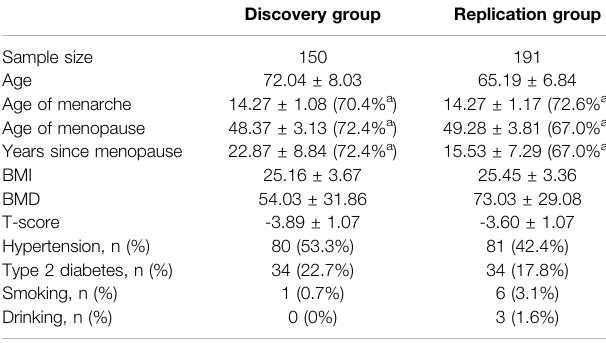
TABLE 1 | PMO-related characteristics of the participants. Discovery group Replication